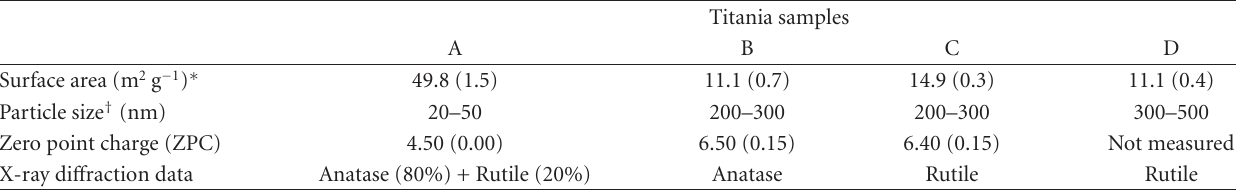
Table 1: Selected characteristics of titania samples.